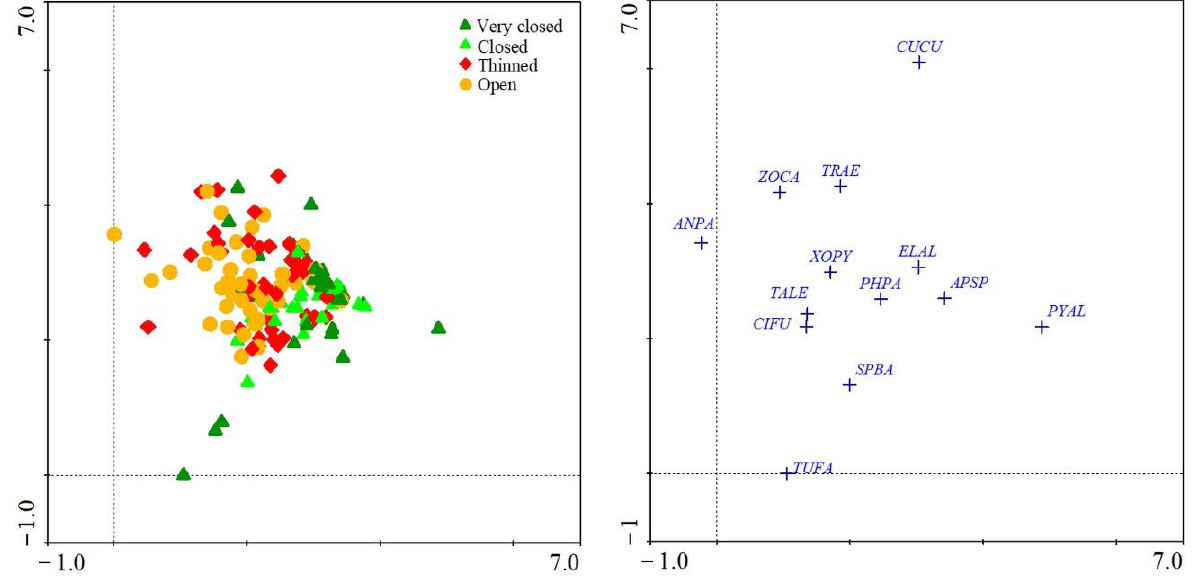
Figure 3. DCA ordination of Nothofagus antarctica forests (very closed, closed, thinned, and open) based on bird density data in Tierra del Fuego, Argentina, showing revisit in plots to the left and species to the right. Species acronyms are shown in Table 2.